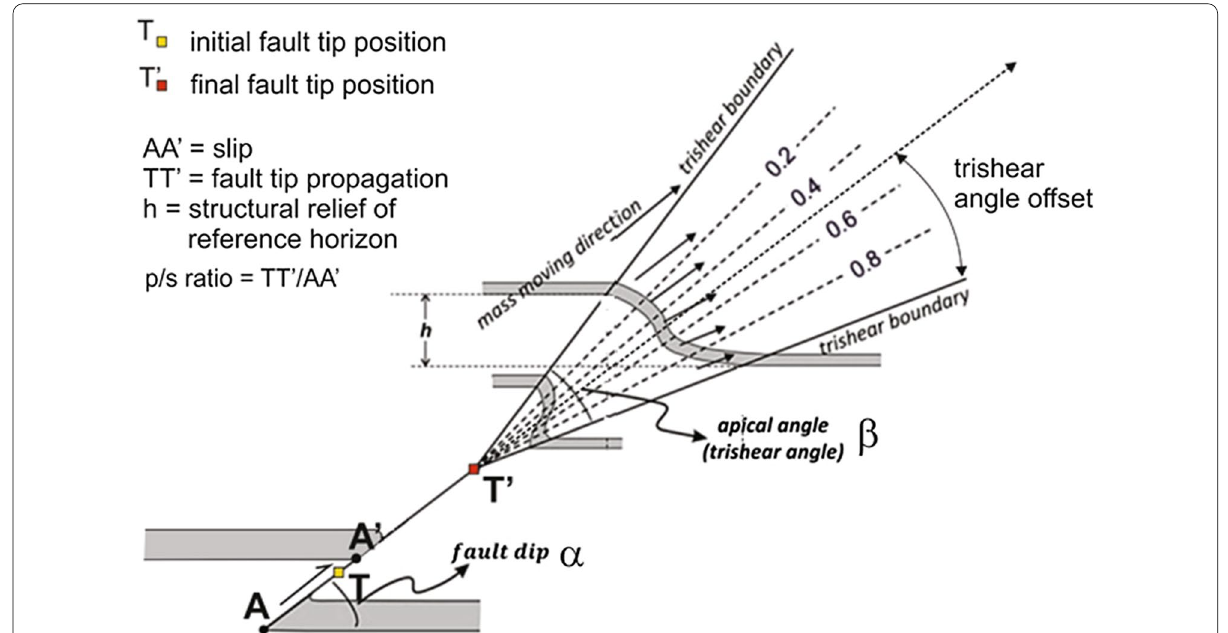
Fig. 4 The trishear kinematic model (modified after Pei et al., 2014), based on Erslev